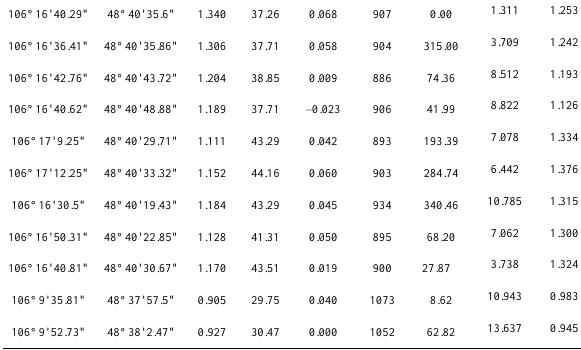
Table 6. SM related drivers in Bornuur soum (additional points) The results of the PSMI model was compared with the ground SM measurement (traditional) data in Tuv province ( r 2 =0.65). The output map from the modelling for kastanozems soil is shown in the Figure 10. The maximum value of PSMI data is 1.56, the minimum is 0.0. We divided PSMI into 3 classes which are low (0.0~1.0), moderate (1.1~1.5) and high (1.6~high). Also, we classified ground truth measurements into 3 similar classes (low, moderate and high). We overlaid randomly our ground truth points on the map and made validation. In Table 6, we present the matrix evaluation for the validation. The result of PSMI was compared with ground truth measurement (table 7). PSMI result was compared with SM distribution model Erdenetsetseg (1996). The correlation coefficients were respectively 69% and 66% respectively. Producer's Commiss Classes derived from satellites accuracy ion (%) 0-1.0